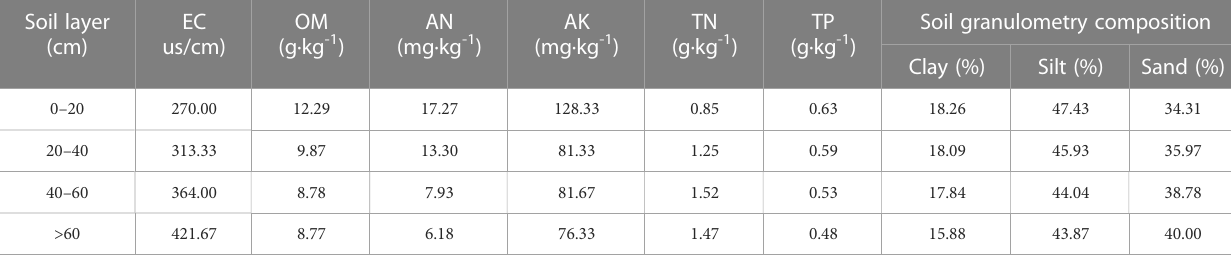
TABLE 1 Physicochemical properties of the experimental